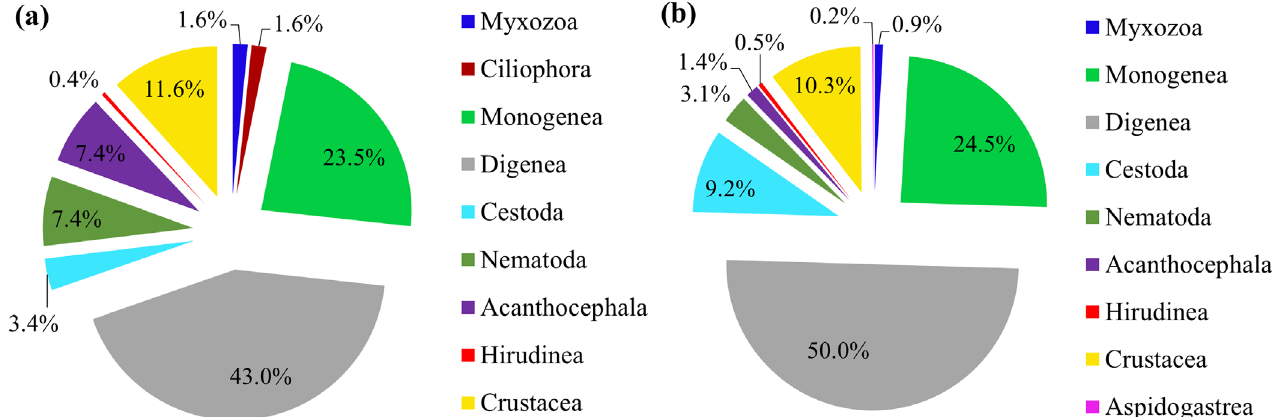
Figure 2. Proportion (%) of (a) the recorded fi sh parasite species in Vietnam (498 species, present study), and (b) fi sh parasites species in Hawaii (652 species [103]).